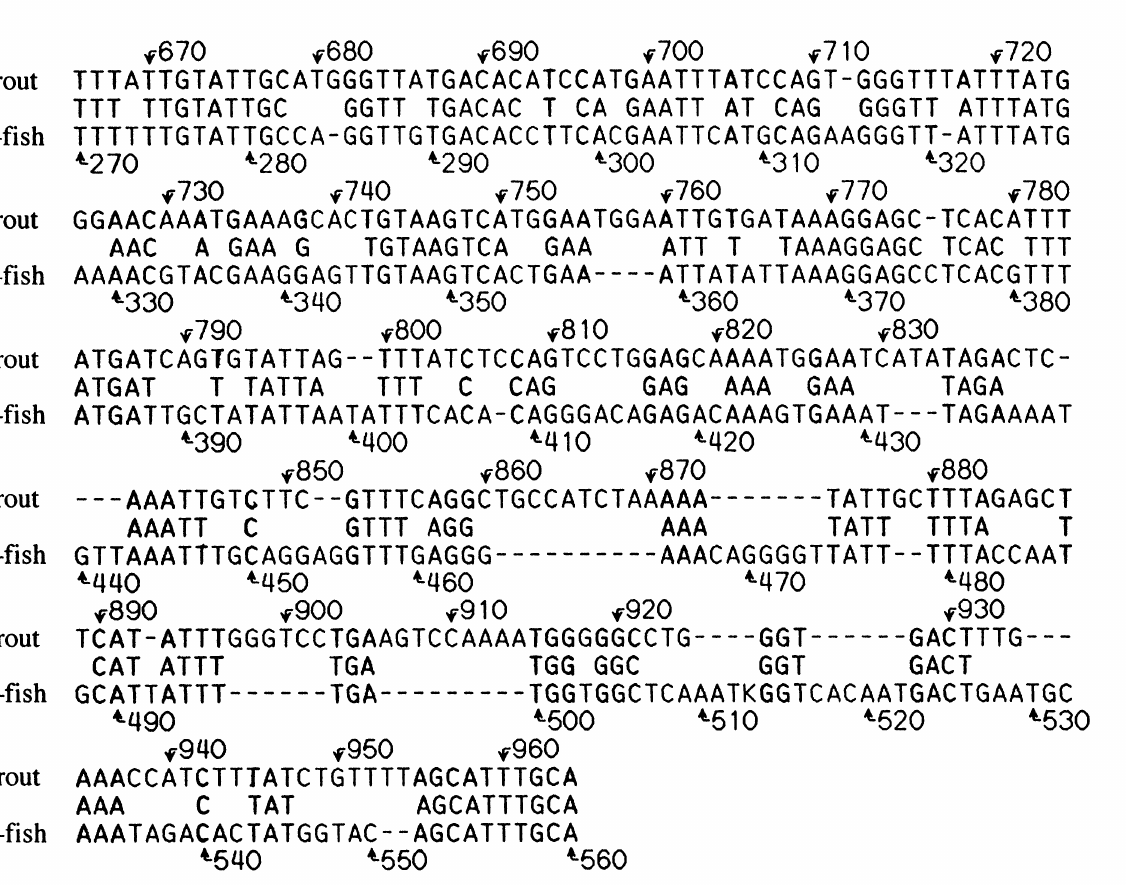
FIGURE 3 The trout and zebrafish RAG intergenic regions contain a region of homology. Shown is a 290 base pair region of the zebrafish and trout RAG locus intergenic regions that is 50% similar. The middle line lists the base pairs in common. Numbering refers to accession numbers U73750 (trout) and U69610